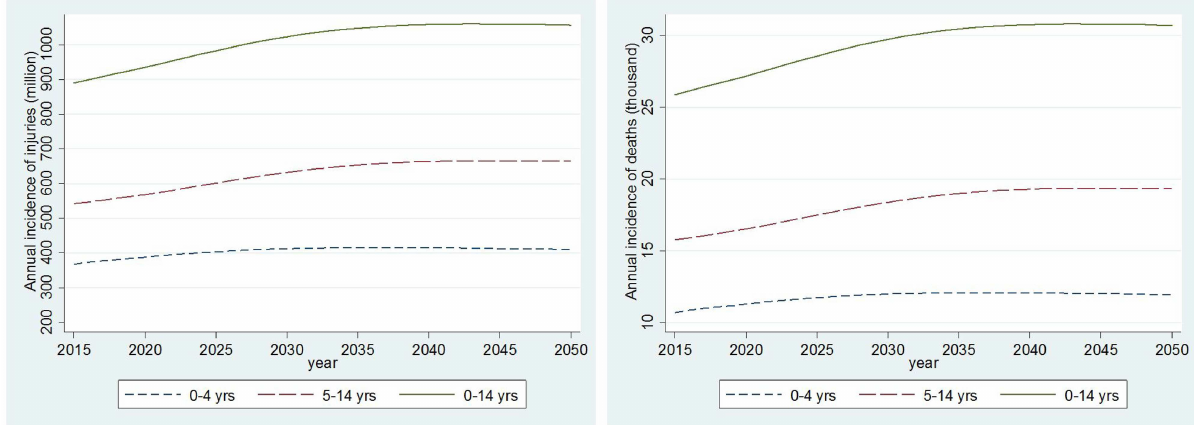
Fig 6. Predicted annual incidence of injuries and deaths in Ethiopia: 2015–2050.